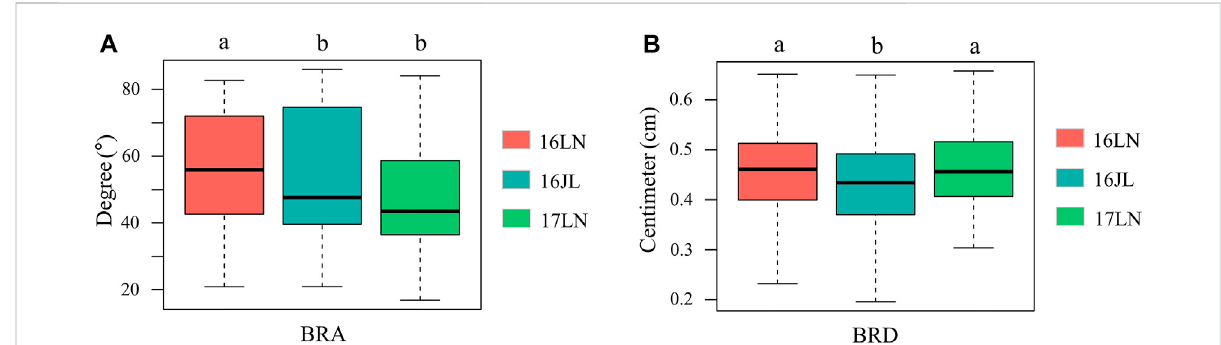
FIGURE 2 Boxplot of BRA and BRD of the three environments. (A) BRA, (B) BRD. ANOVA was used to examine phenotypic differences between different environments. a and b indicate statically signi fi cant differences at p ≤ 0.05. 16LN , Liaoning Province in 2016; 16JL , Jilin Province in 2016; 17LN , Liaoning Province in